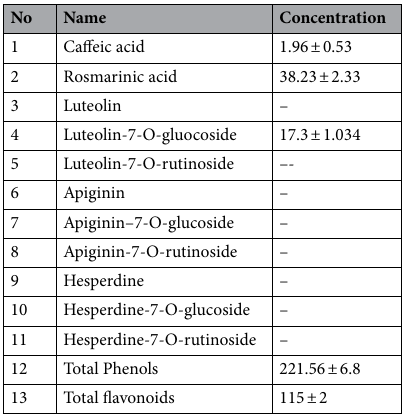
Table 2. Total Phenolic and flavonoids compounds identified in ethanolic extract of Thymus vulgaris for triplicate samples.